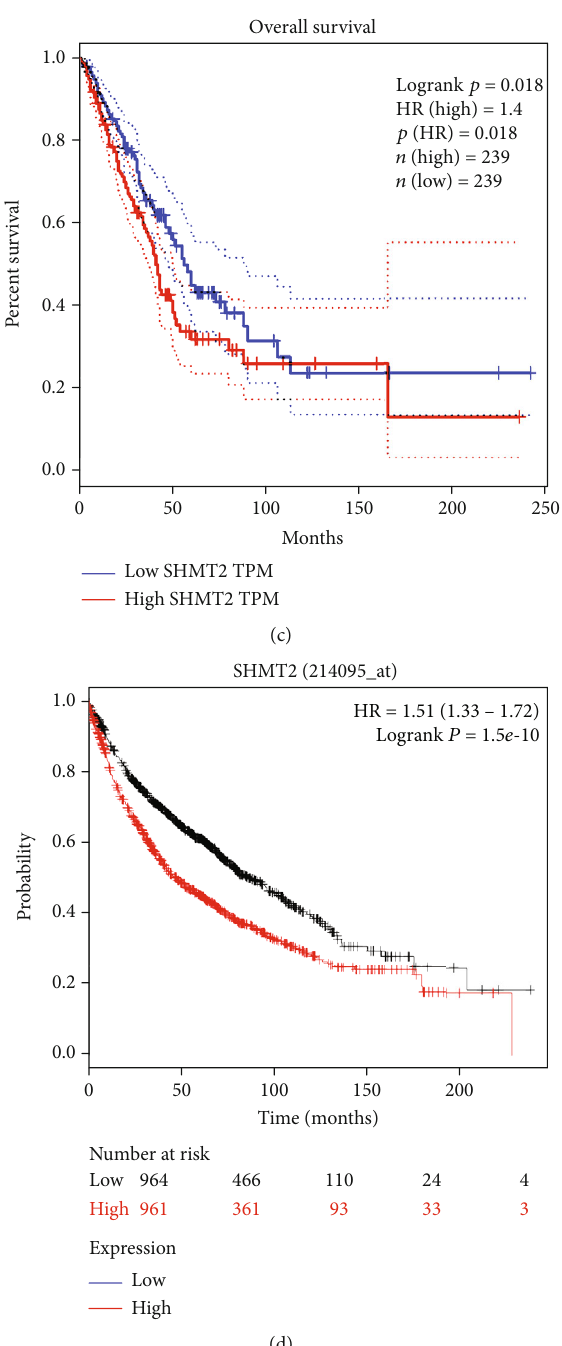
Figure 8: Kaplan-Meier survival analysis. (a) OS (overall survival) of SHMT2 in GSE21933. (b) OS (overall survival) of SHMT2 in GSE31210. The numbers below the fi gures represent the number of patients at risk in each group. (c and d) Kaplan-Meier survival curves comparing the high and low expression of SHMT2 in LUAD in the Kaplan-Meier plotter database and GEPIA